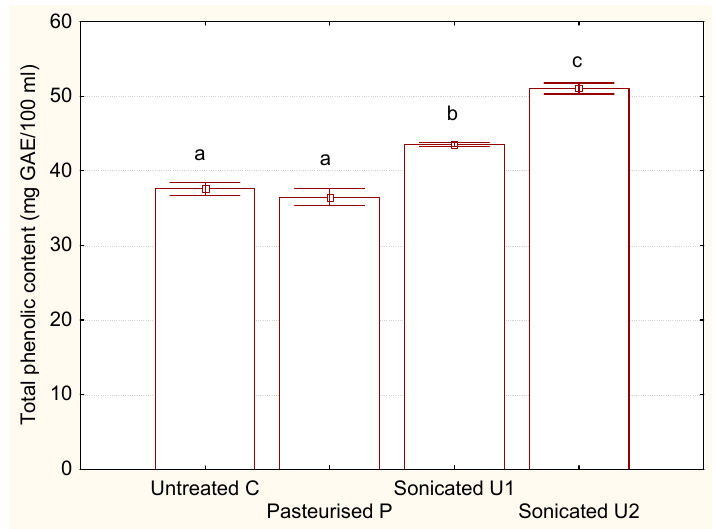
Figure 3. Effect of preservation method on total phenolic content in apple juice. Error bars represent standard deviations. Values that share the same letter are not significantly different at P < 0.05.